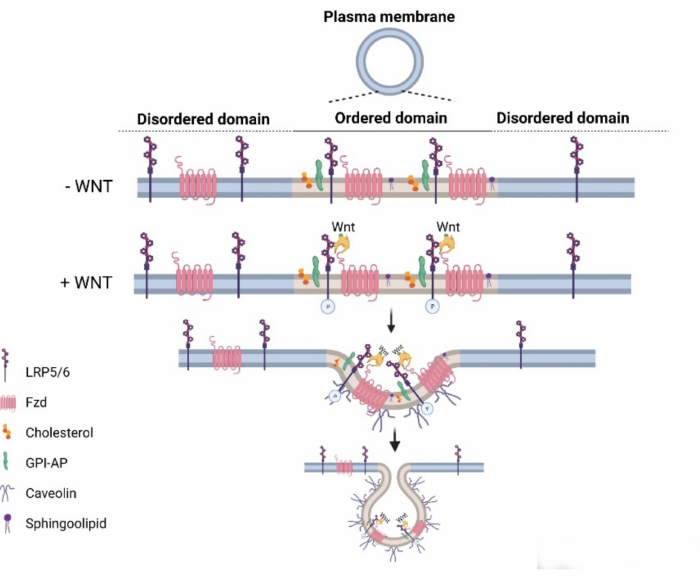
Figure 2. Canonical Wnt signaling activity is controlled by components of the plasma membrane. In general, the ordered domains are enriched in cholesterol, glycolipids, and caveolin. The ordered domains are necessary for the binding of the canonical Wnt ligand to its (co)receptors, Lrp5/6 phosphorylation, receptor endocytosis, and signaling activity. Created with